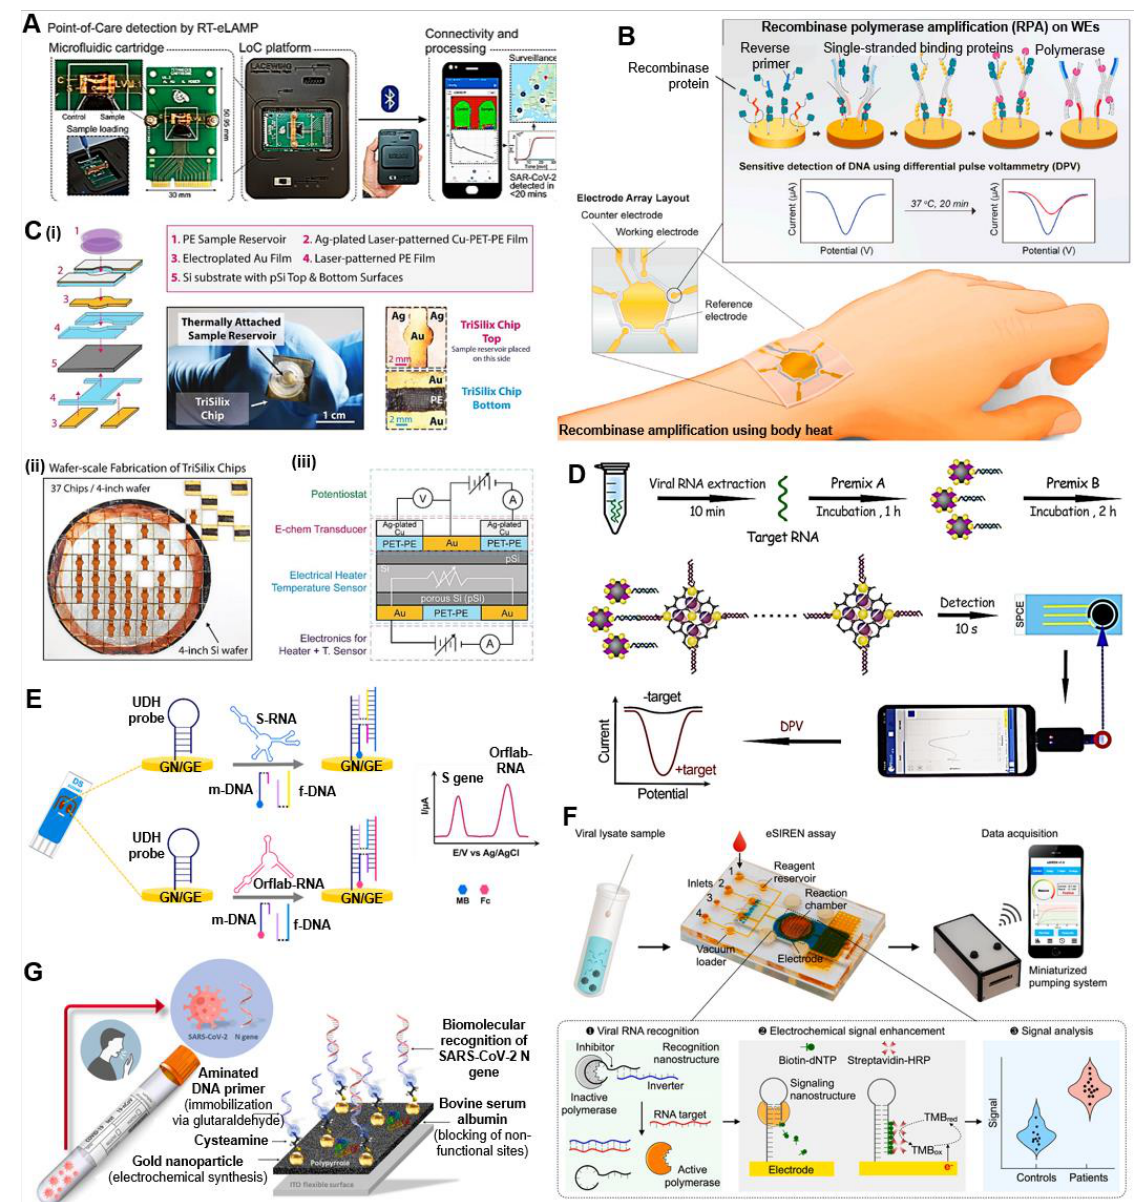
Figure 2. Chip-based POC electrochemical NAT. ( A ) Handheld LOC-coupled microfluidic RT- eLAMP and subsequent ISFET-based electrochemical detection of SARS-CoV-2 RNA. The platform enables smartphone-integrated real-time result visualization and geo-mapping. Reproduced with permission from [65]. Copyright 2021, American Chemical Society published under an ACS Author-